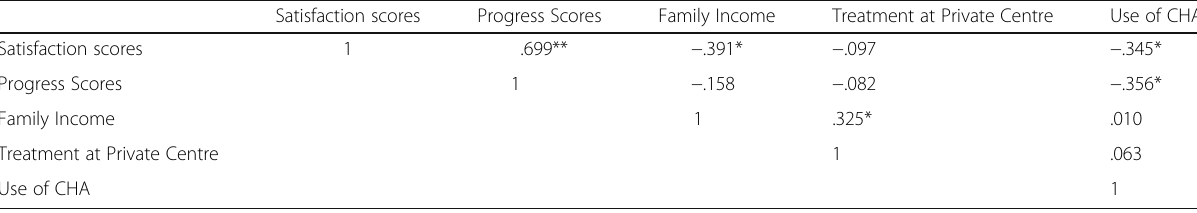
Table 4 Correlation of parental satisfaction and child ’ s progress scores with related factors Satisfaction scores Progress Scores Family Income Treatment at Private Centre Use of